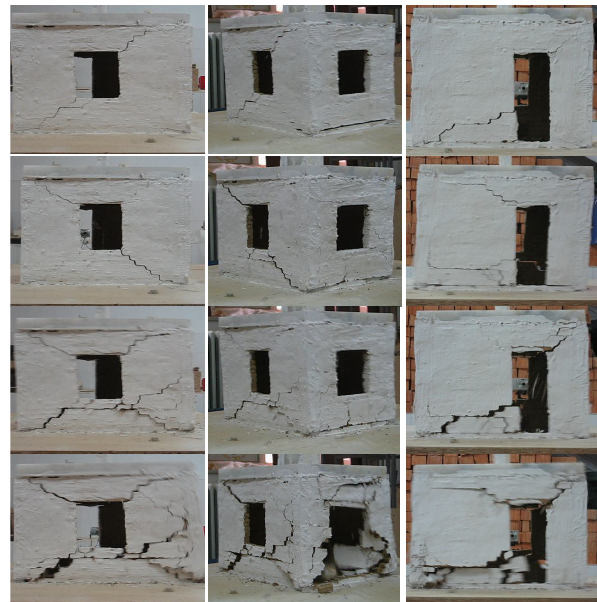
Fig. 14 Failure sequence of specimen CF3